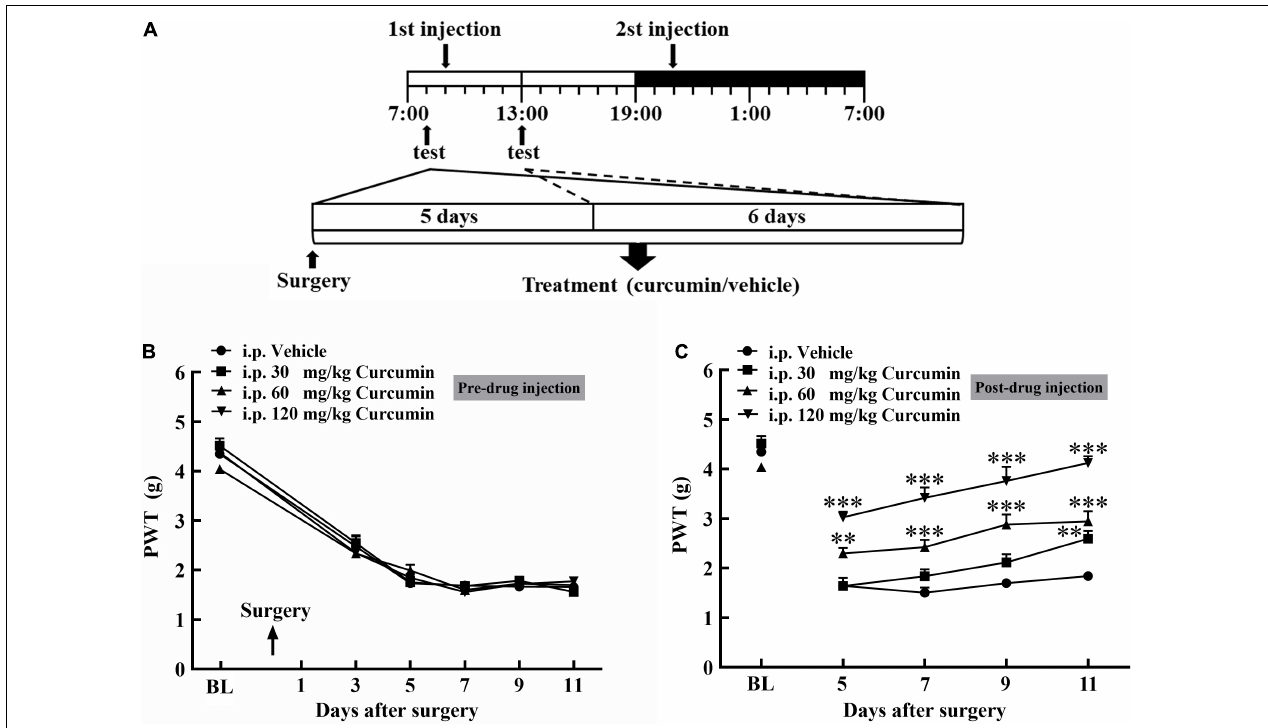
FIGURE 1 | Chronic treatment with curcumin inhibited B16-F10 melanoma cell-induced bone cancer pain behavior in mice in a dose-dependent manner. Schematic of experiment (A) . Mice were injected with B16-F10 melanoma cells (1 × 10 5 , 5 µ l) and then treated with curcumin (30, 60, and 120 mg/kg, i.p.) twice daily for 11 days starting at 24 h after tumor injection. The withdrawal threshold before the injection was measured on the 3rd, 5th, 7th, 9th, and 11th day (B) and after the injection was measured on the 5th, 7th, 9th, and 11th day (C) . Data are shown as means ± SEM, n = 7 per group. * P < 0.05, ** P < 0.01, and *** P < 0.001 compared with the vehicle group, one-way ANOVA followed by Dunnett’s